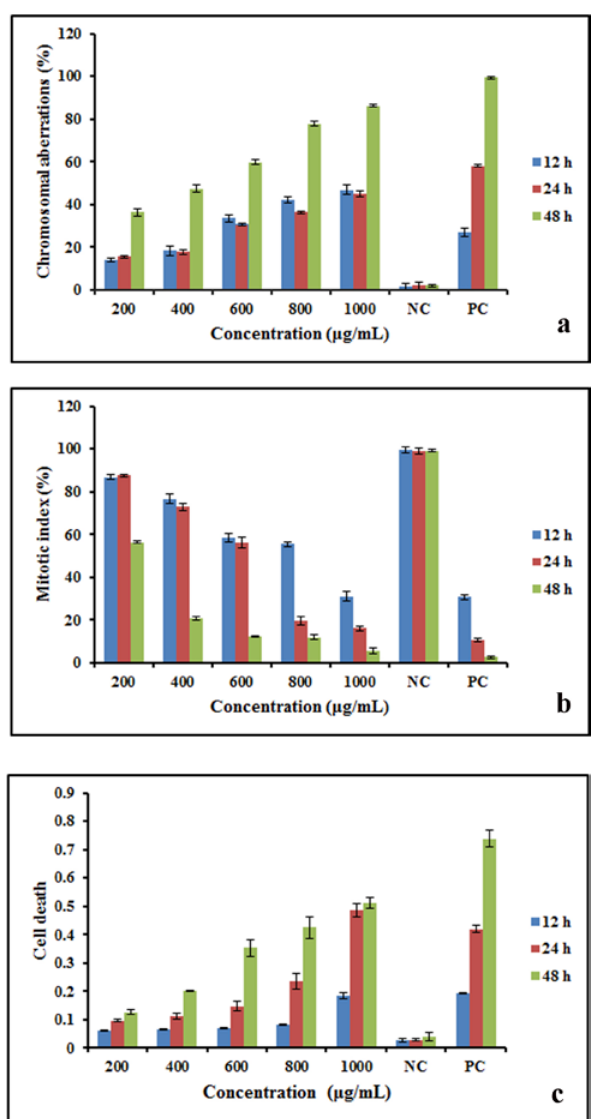
Fig. 2. a: Determination of chromosomal aberrations on A. cepa by C. viminale; b: Mitotic index; c: Spectrophotometric determination of cell death by Evans blue